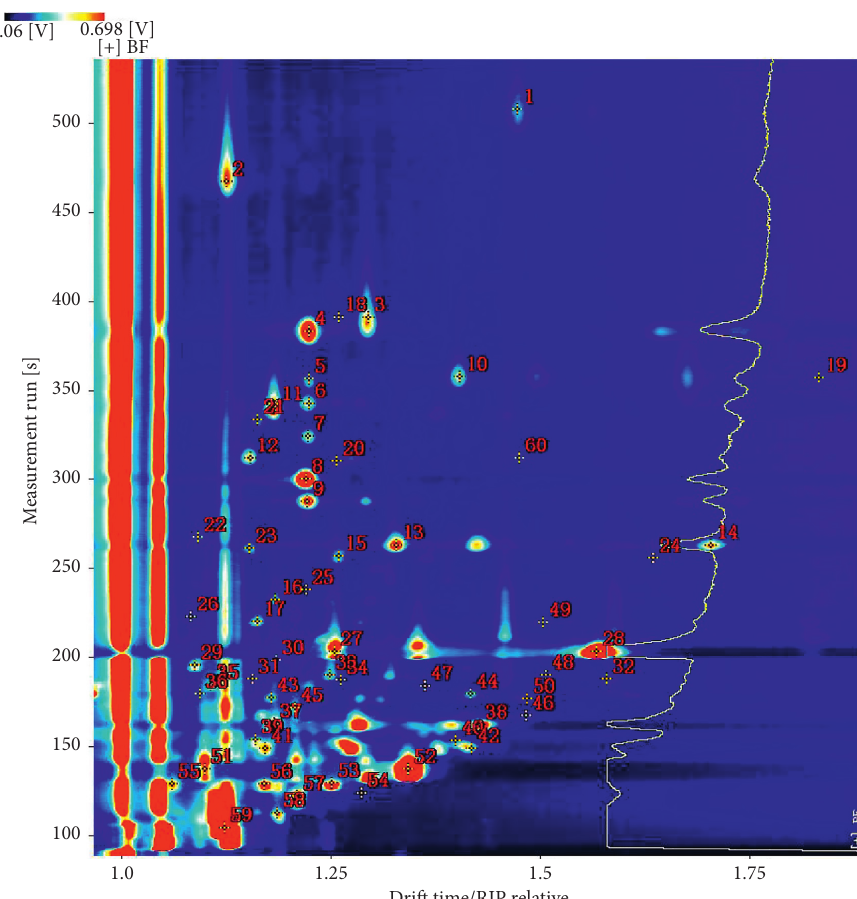
Figure 3: IMS qualitative analysis of volatile flavor substances of giant salamander meatball before